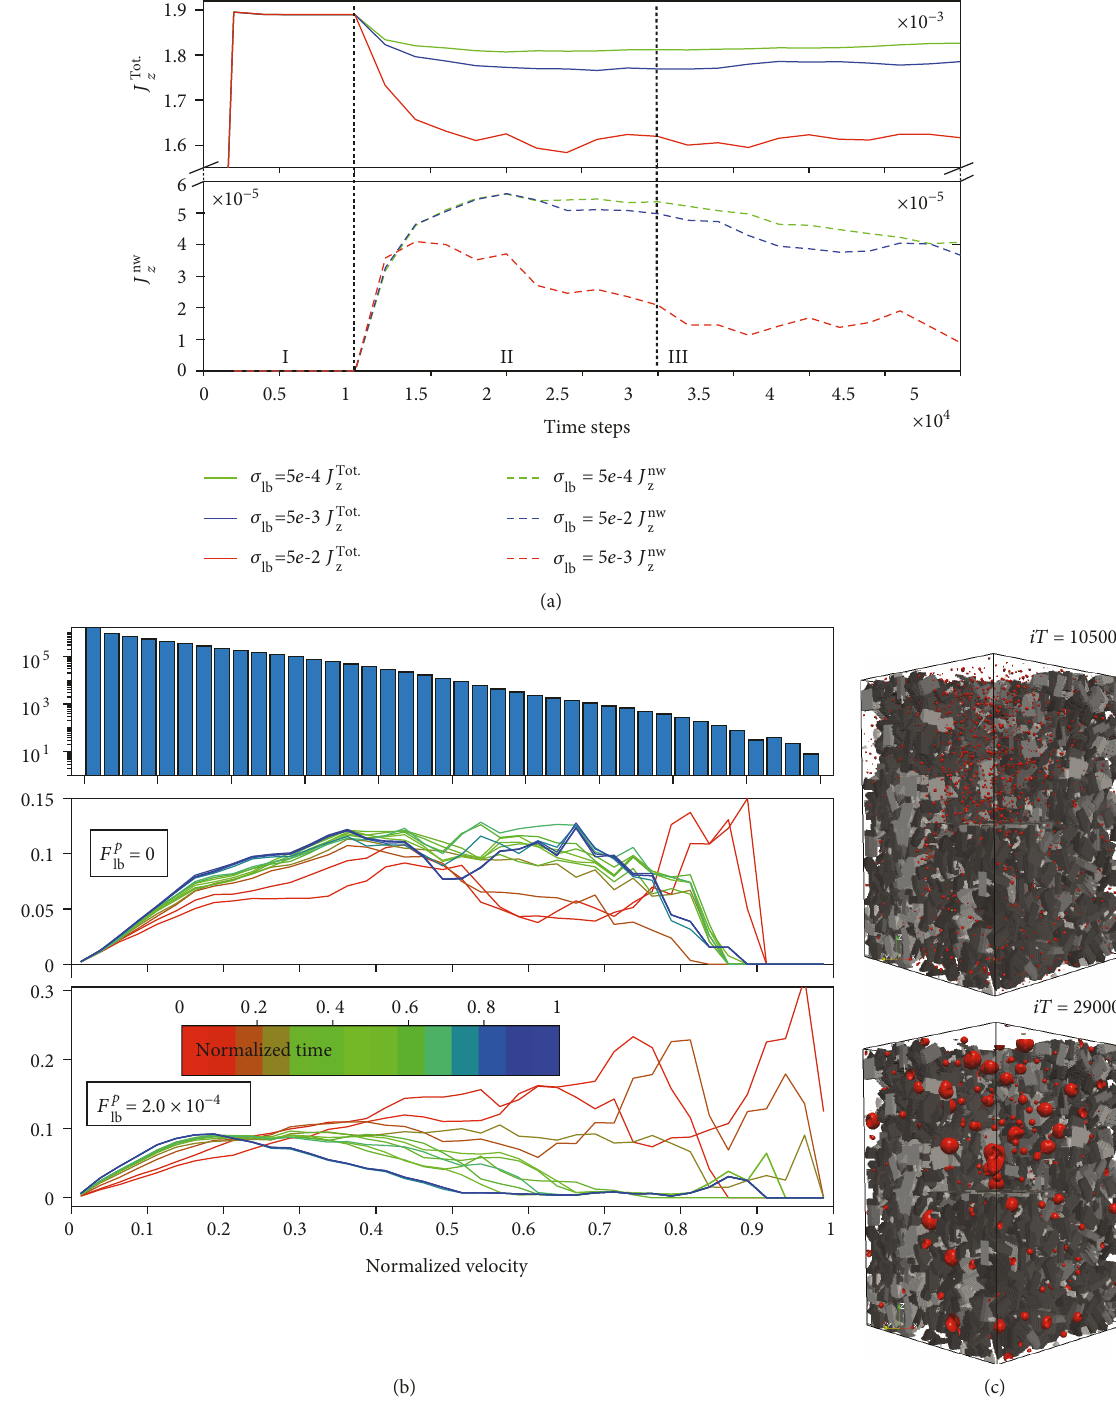
Figure 1: (a) Three-stage (i.e., stages I, II, and III) temporal evolution of total discharge, J tot , and non-wetting fl uid discharge, J nw , for three Z Z = 0 05 . (b) Temporal evolution of S 6 × 10 5 ) σ lb values and S nw nw distribution (simulation time is normalized to the maximum lattice time of as a function of porous medium conductivity for null (middle panel) and non-null (bottom panel) hydraulic gradients with σ lb = 0 05 and S nw = 0 05 . The top panel shows the histogram of the normalized velocity. (c) Droplet evolution at two di ff erent times (early and later times at stage II) during spinodal decomposition for σ lb = 0 05 , S nw = 0 05 , and F p lb = 2 0 × 10 − 4